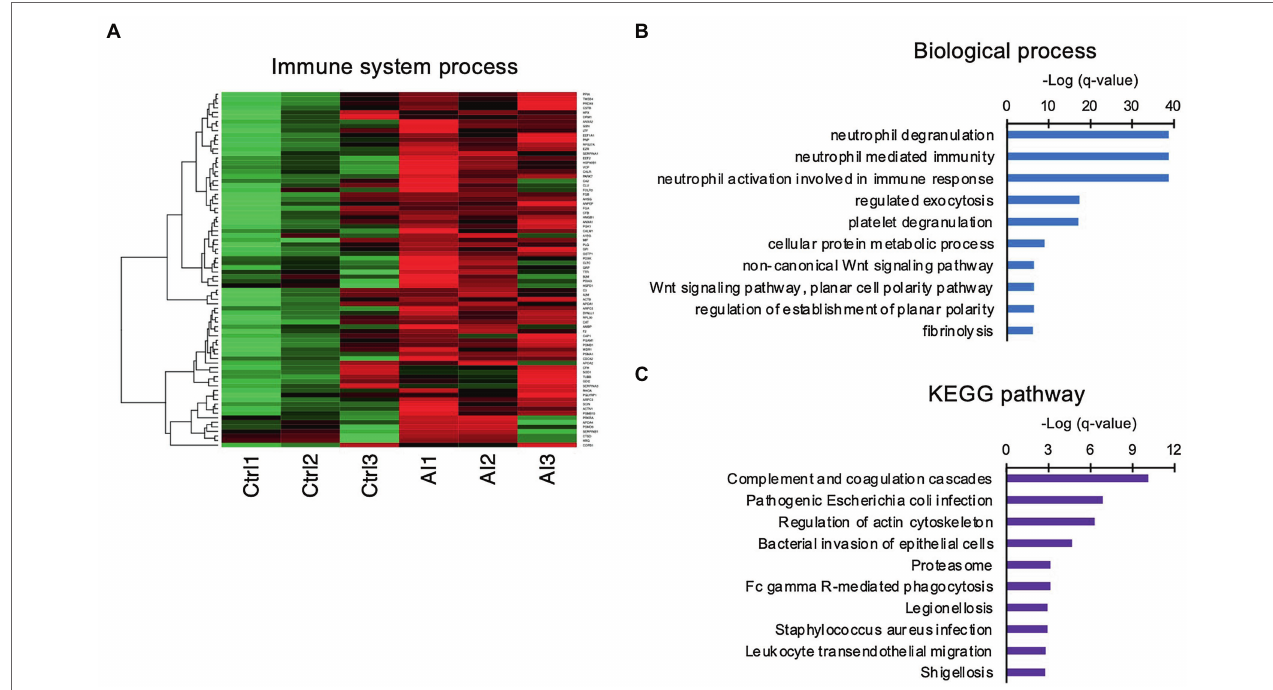
FIGURE 3 | Involvement of innate immune functions in the UF obtained on D7. (A) Heat-map study of innate immune system-related genes in UF of inseminated (AI) and non-inseminated (Ctrl) cows. High-concentration proteins are shown in red, and low-concentration proteins are shown in green. (B,C) Identified immune system-related genes were functionally classified in biological GO terms (B) and enriched pathway analyses (C)